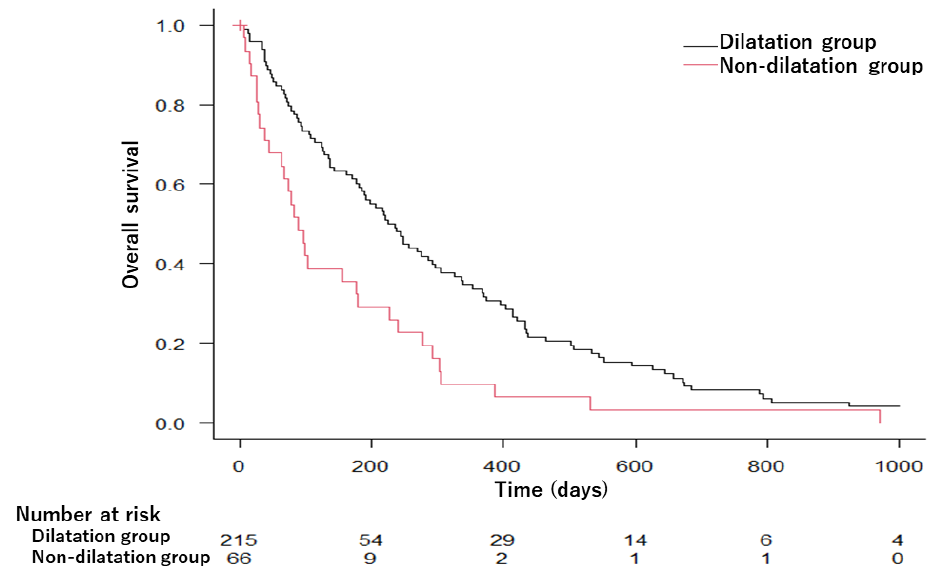
Figure 2. Kaplan–Meier survival curves comparing overall survival in the dilatation and non-dilatation groups. MST was 230 days in the dilatation group and 88 days in the non-dilatation group ( p = 0.001). MST, median survival time.